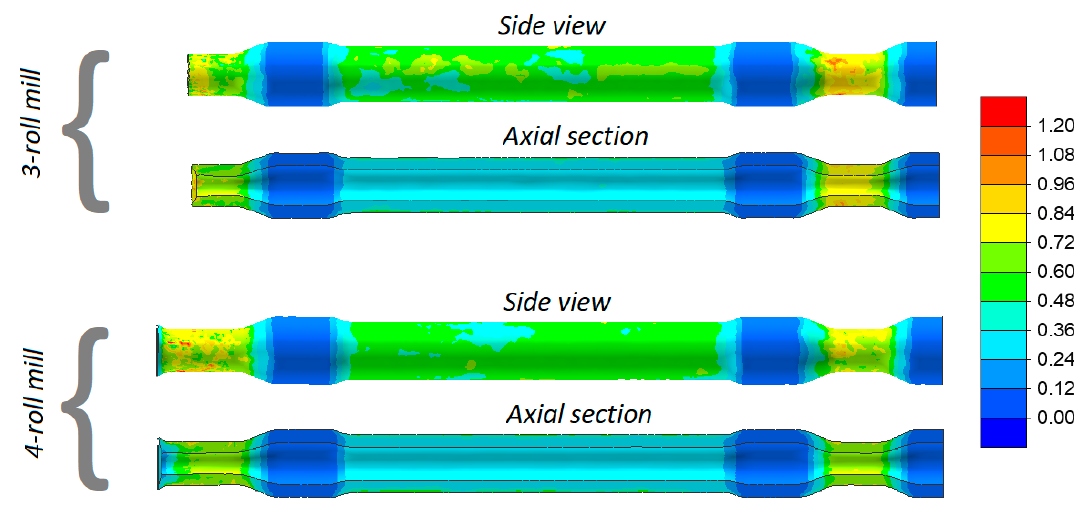
Figure 16. Distribution of the damage function (based on the normalized Cockcroft–Latham criterion) in skew rolled hollow axles.